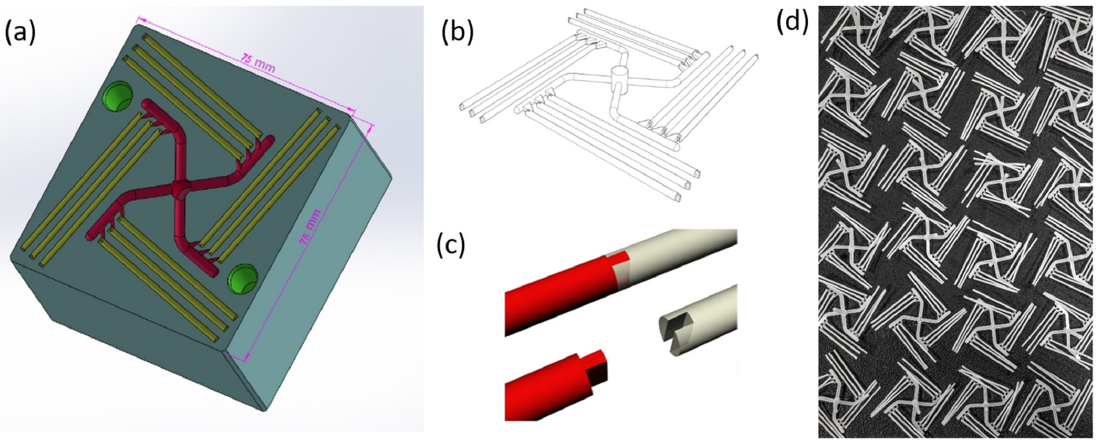
Figure 1. ( a ) CAD model of the mold used in the research, ( b ) designed model of the part, ( c ) scheme of connecting sticks, ( d ) produced parts with sticks. of connecting sticks, ( d ) produced parts with